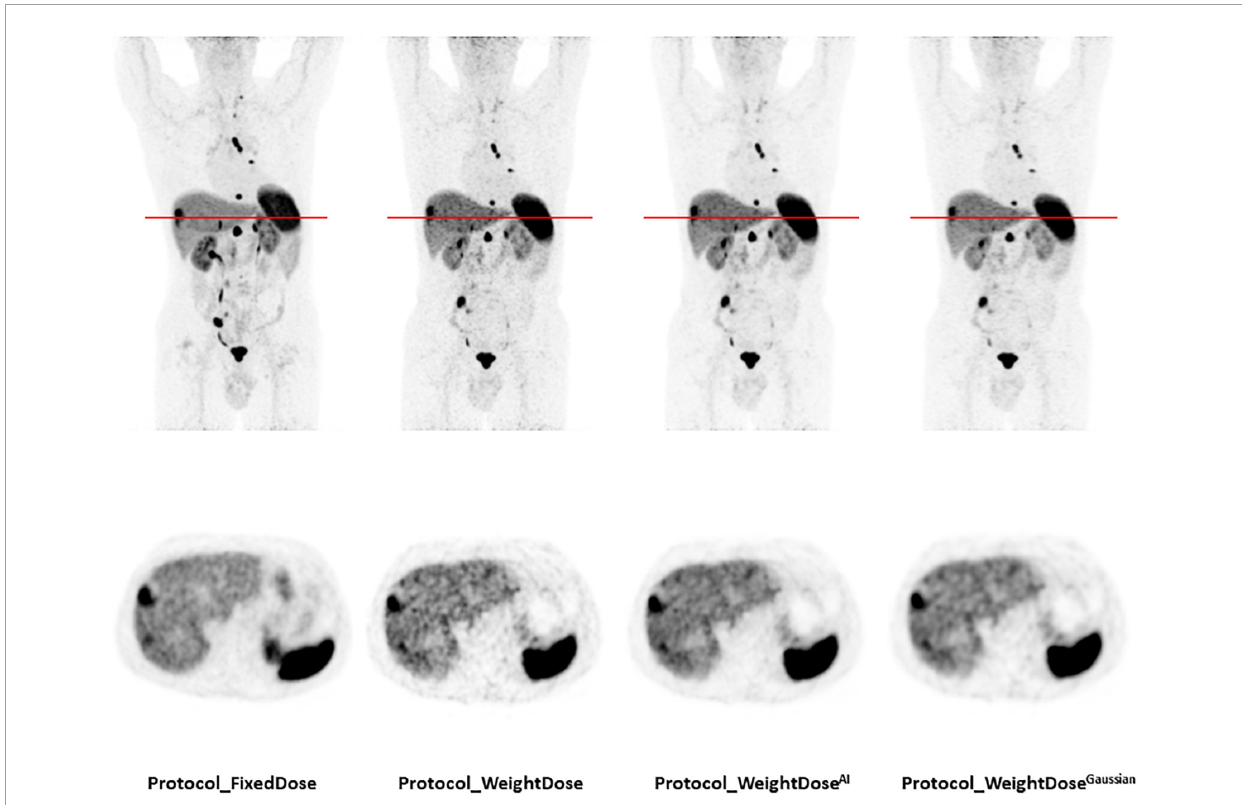
FIGURE3 Representative images of a patient who underwent all four protocols during the inclusion period. A total of 77-year-old man of normal weight (BMI = 21.3 kg/m 2 ) with a well-differentiated metastatic pancreatic neuroendocrine tumour (grade 1, Ki 67 < 1%). Injected doses were 158 MBq (2.4 MBq/kg) for protocol_FixedDose and 86 MBq (1.3 MBq/kg) for protocol_WeightDose , protocol_WeightDose AI and protocol_ WeightDose Gaussian . All images are scaled to the same SUV max